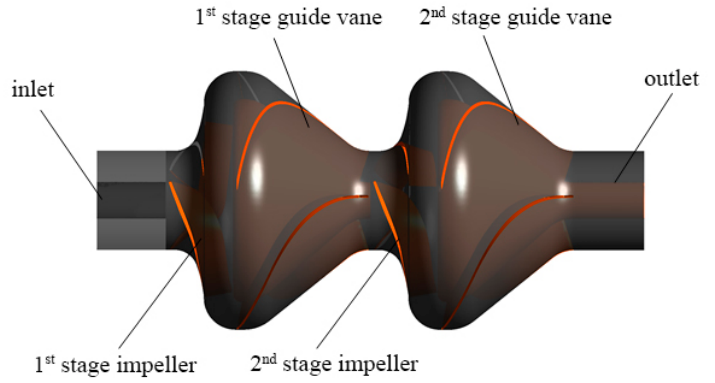
Figure 5. Single-stage impeller and guide vane model.